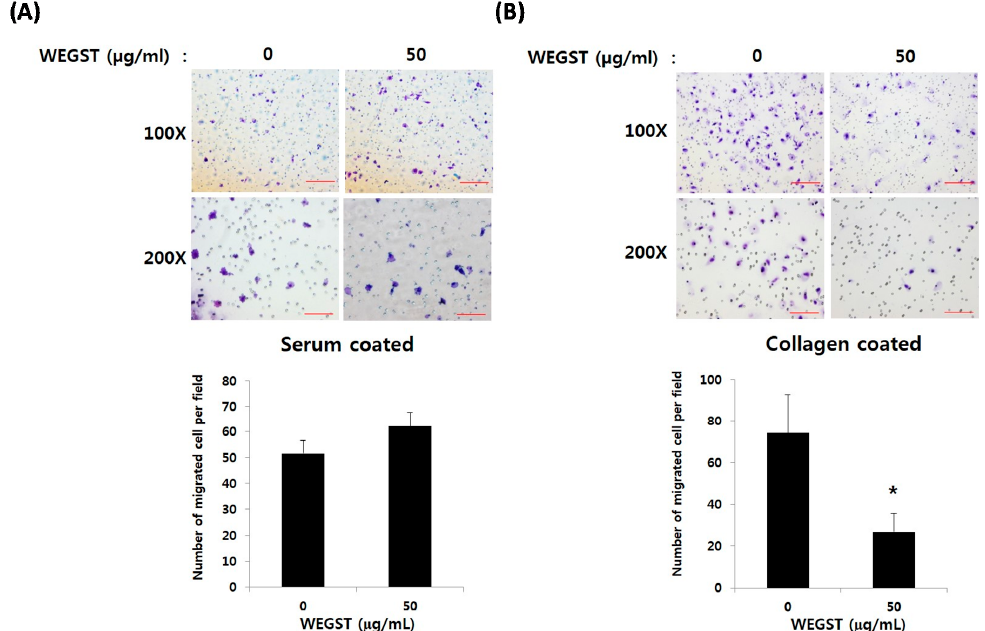
Figure 2. WEGST-attenuated collagen-mediated migration. PC3 cells were pre-treated with WEGST (50 µg/mL) for 6 h and seeded in a chamber of 20% serum ( A ) and collagen I ( B ) coated on the bottom layer of the Transwell membrane. Cells that migrated to the bottom part of the Transwell membrane were fixed with paraformaldehyde (4%, w / v ) for 10 min and then stained with crystal violet solution (0.5%, w / v ), and counted. A representative figure of three independent experiments is shown in the upper panels, with two different magnifications (100× and 200×). The number of cells was counted in four different fields and tabulated in the bottom panel. Error bars refer to the SD of the mean. Bar = 0.1 µm of 200× magnification and 0.2 µm of 100× magnification. * p < 0.05, compared with non-treated PC3 cells (0 µg/mL of WEGST).